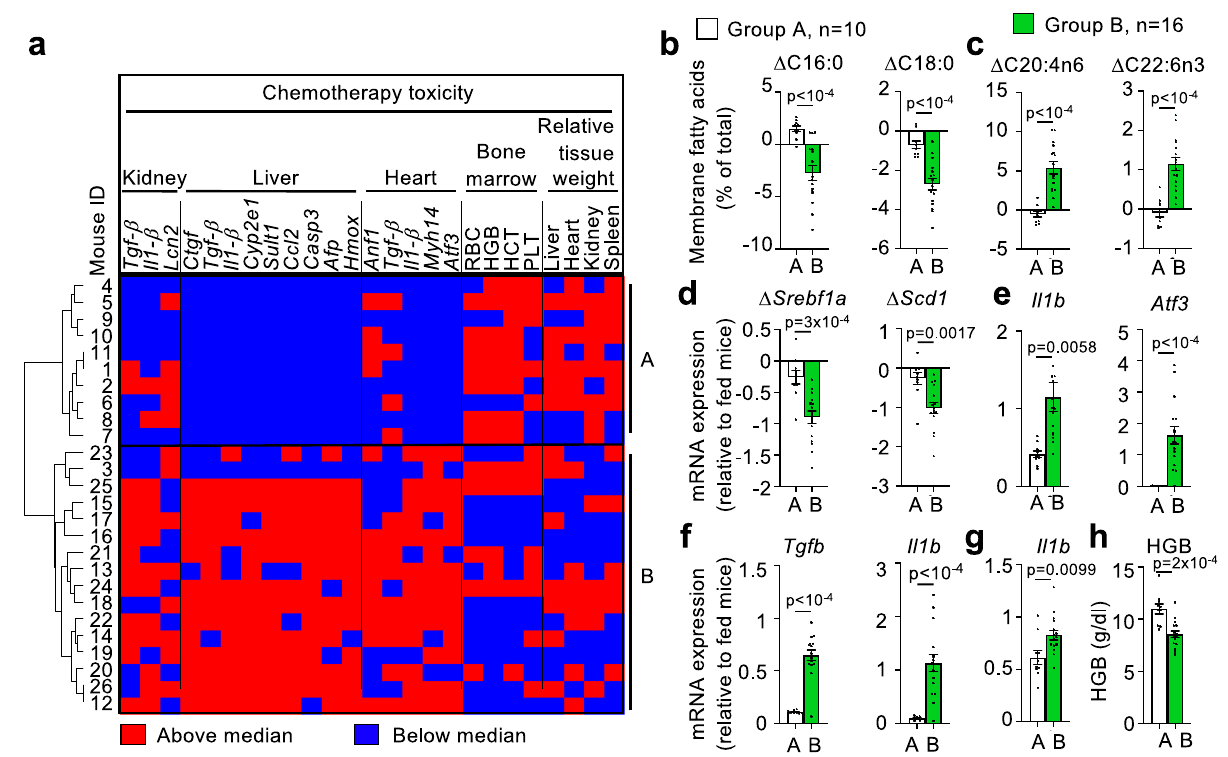
Fig. 7 | Groups of individuals responding differently to fasting predict fasting- mediated protection from chemotherapy. a Heatmap depicting the position of each individual (represented by a number next to each row) with respect to the median value for each of the indicated parameters. Red indicates “ above the median ” ,andblueindicates “ belowthemedian ” .Individualsareorderedaccording to the groups A and B found in Fig. 4f. RBC red blood cells. HGB hemoglobin. HCT hematocrit.PLTplatelets. b – h ComparisonbetweengroupsA( n =10)andB( n =16)